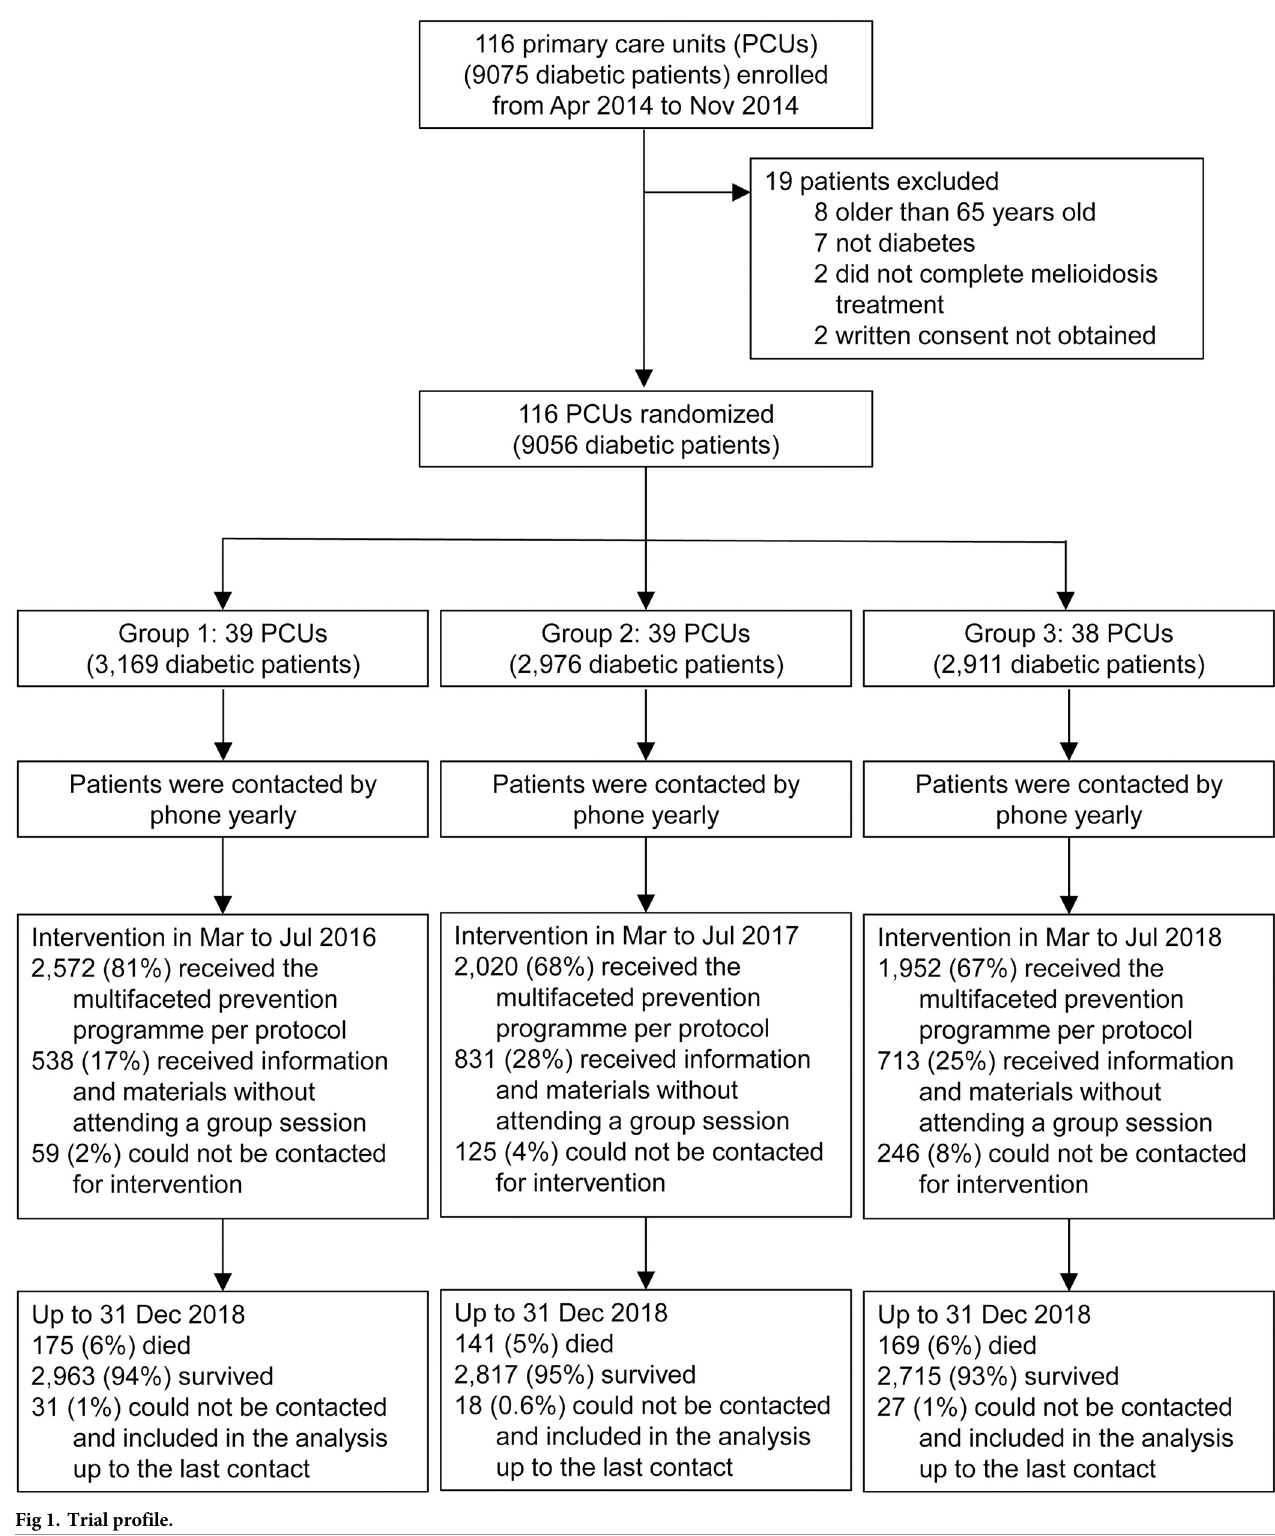
PLOS NeglectedTropical Diseases | https://doi.org/10.1371/journal.pntd.0009060 June 25, 2021 5 /